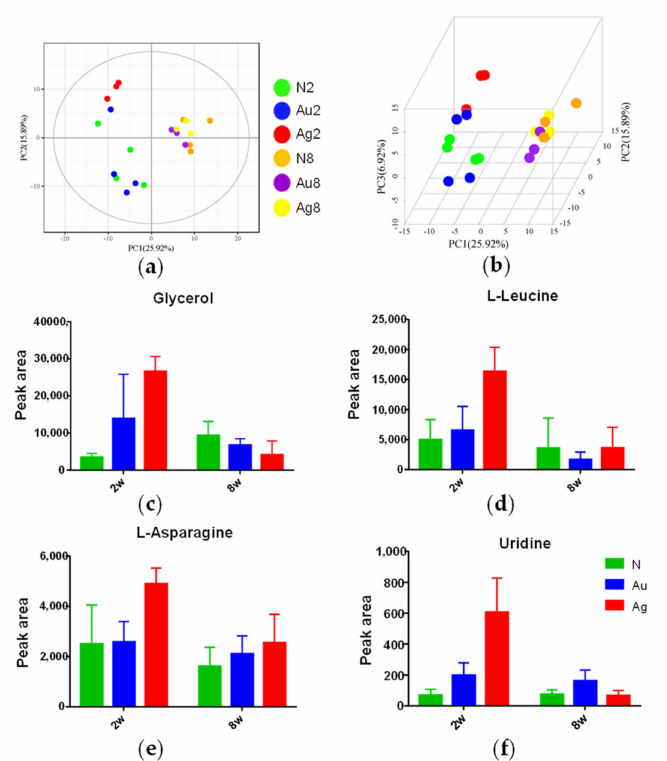
Figure 6. The PLA-DA score plots of metabolic profiles in liver tissues after the treatment of AuNRs or Au@Ag NRs. The score plot of PLS-DA multivariate analysis at ( a ) 2 w and ( b ) 8 w. (N2, the control group at 2 w; Au2, the AuNRs group at 2 w; Ag2, Au@Ag NRs at 2 w; N8, the control group at 8 w; Au8, the AuNRs group at 8 w; Ag8, Au@Ag NRs at 8 w). ( c – f ) The changes of some important metabolites at 2 w or 8